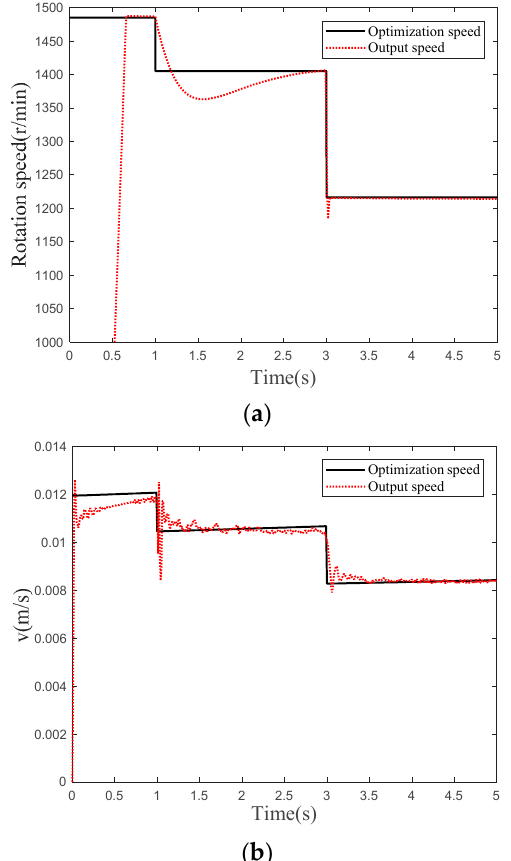
Figure 15. Swing speed and rotational speed results under co-simulation: ( a ) Comparison between the working state and the optimized state of the cutting motor and ( b ) Comparison of working state and optimal state of hydraulic system.